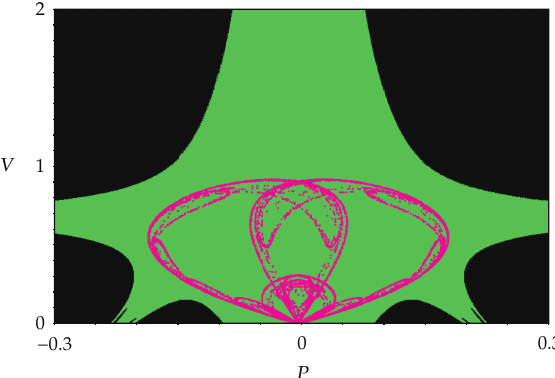
Figure 4: Phase diagram showing chaotic attractor (cid:3) N (cid:8) 3 . 2 (cid:4) .